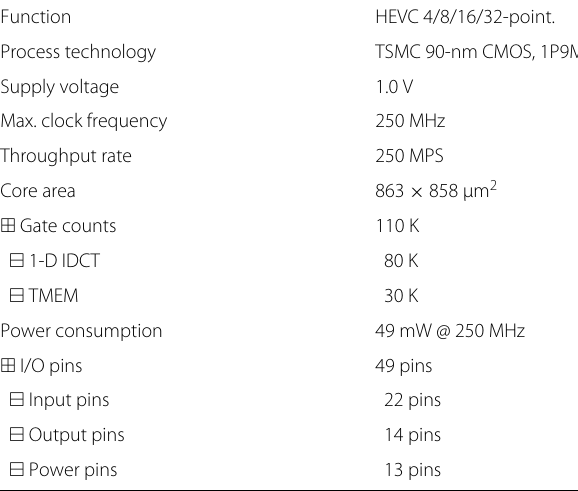
Table 1 Chip characteristics of the proposed 2-D IDCT